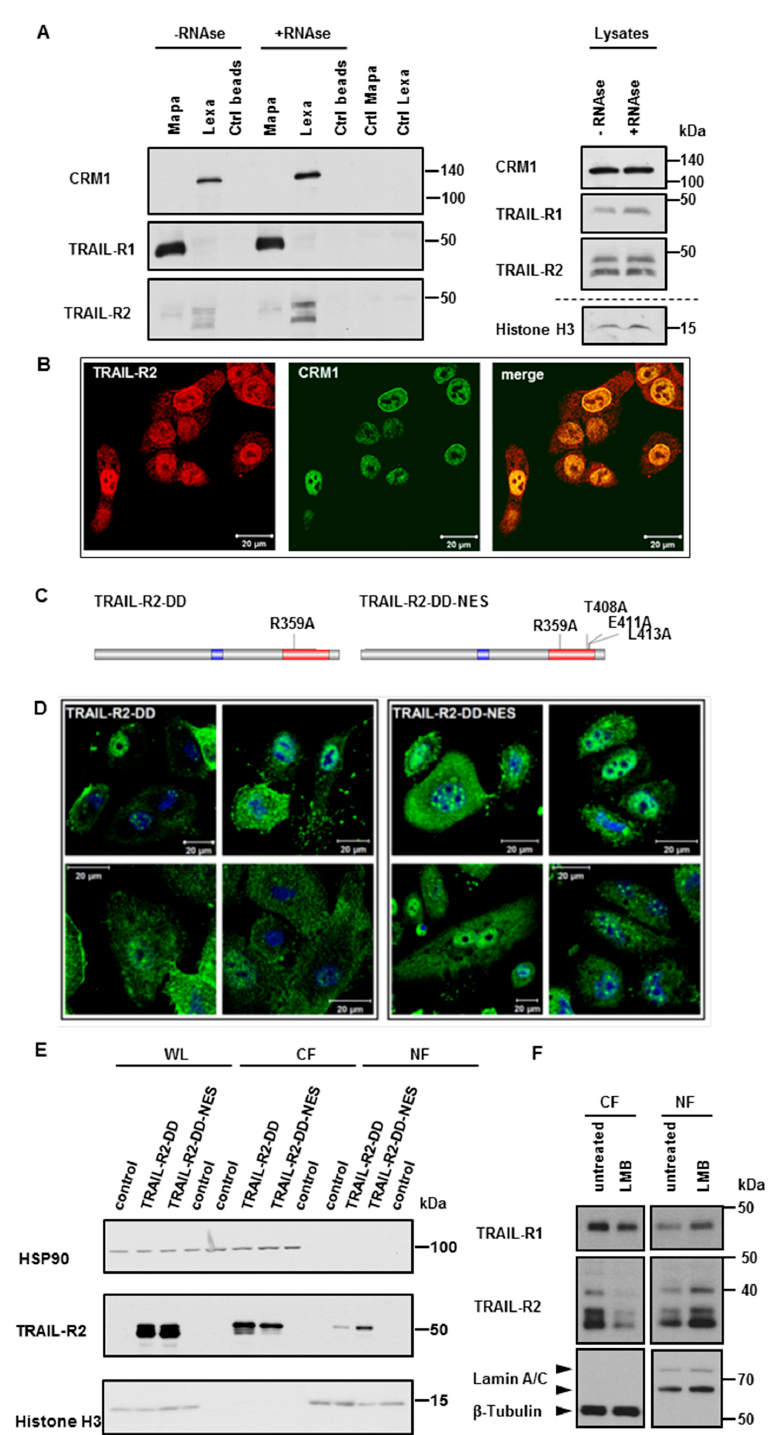
Figure 7. CRM-1 shuttles TRAIL receptors across the nuclear membrane. ( A ) TRAIL-R1 and TRAIL-R2 were immunoprecipitated from nuclear fractions of Panc89 cells using either Mapatumumab (Mapa) or Lexatumumab (Lexa) antibodies, respectively. Protein complexes were analyzed by Western blotting. As control lysates without antibodies (Ctrl beads) and antibodies alone (Ctrl Mapa, Ctrl Lexa) were analyzed in parallel. Immunoprecipitation were also performed with nuclear extracts pre-treated with RNase. Impact of the RNase-treatment on the levels of studied proteins was analyzed by Western blotting. ( B ) Co-localization of TRAIL-R2 with CRM1 in Panc89 cells was analyzed by indirect immunofluorescence and confocal LSM. ( C ) Scheme of TRAIL-R2 constructs with mutated DD